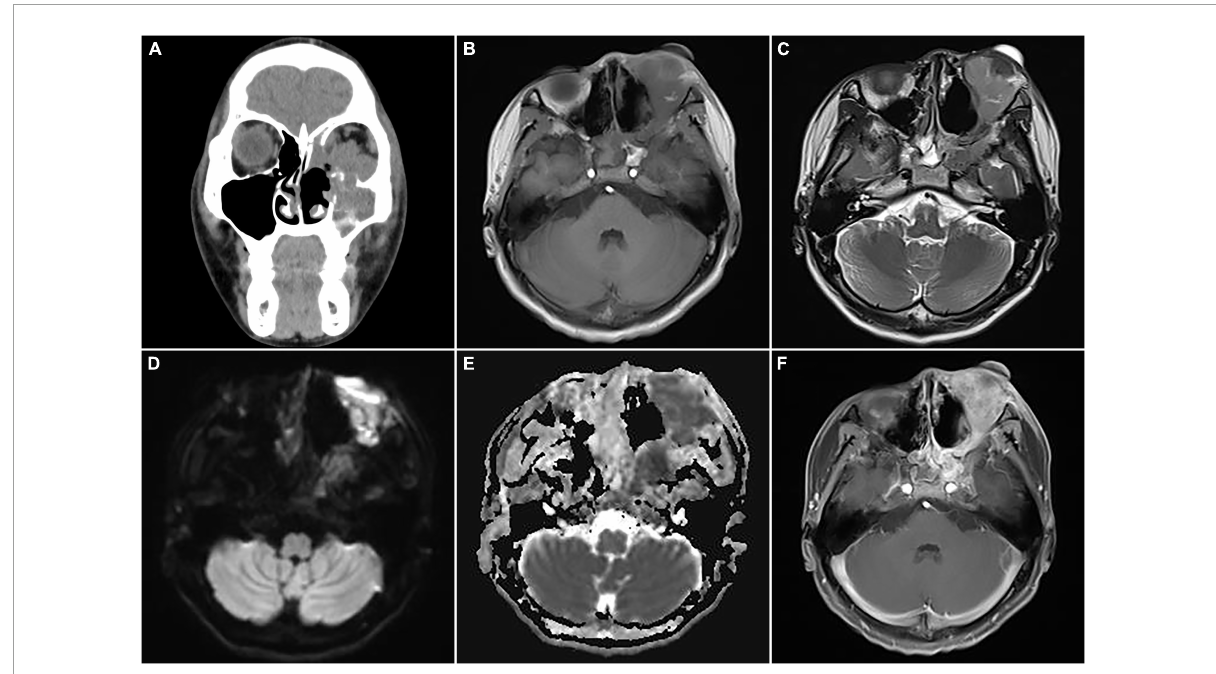
FIGURE8 Computed tomography (CT) images and magnetic resonance imaging (MRI) of postoperative recurrence of alveolar rhabdomyosarcoma (ARMS) in case 2. (A) A coronal CT image showed soft tissue density masses in the sinuses, suggesting recurrence. (B) The lesions showed slight hypointensity on T1WI. (C) Slight hyperintensity on T2WI. (D) Hyperintensity on DWI. (E) Hypointensity on apparent diffusion coefficient (ADC) image. (F) Significant heterogeneous enhancement and compressed left optic